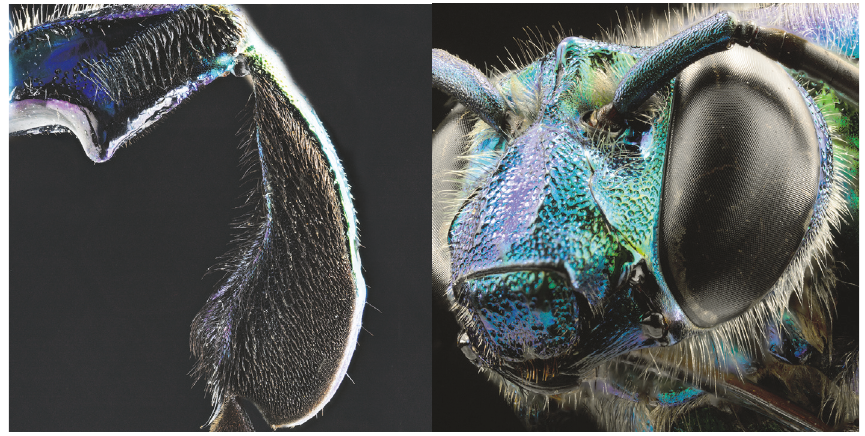
Figure 5: Male hindleg, notably femur (inner view) and head, E. frontalis .